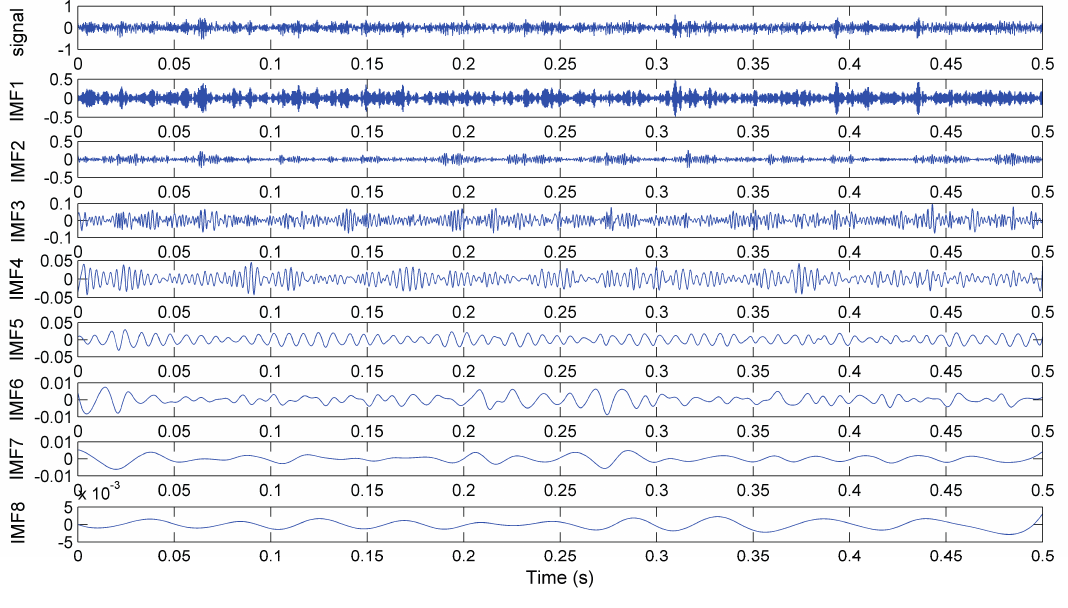
Figure 5. The decomposed components with EEMD for signal from sensor ① at f =